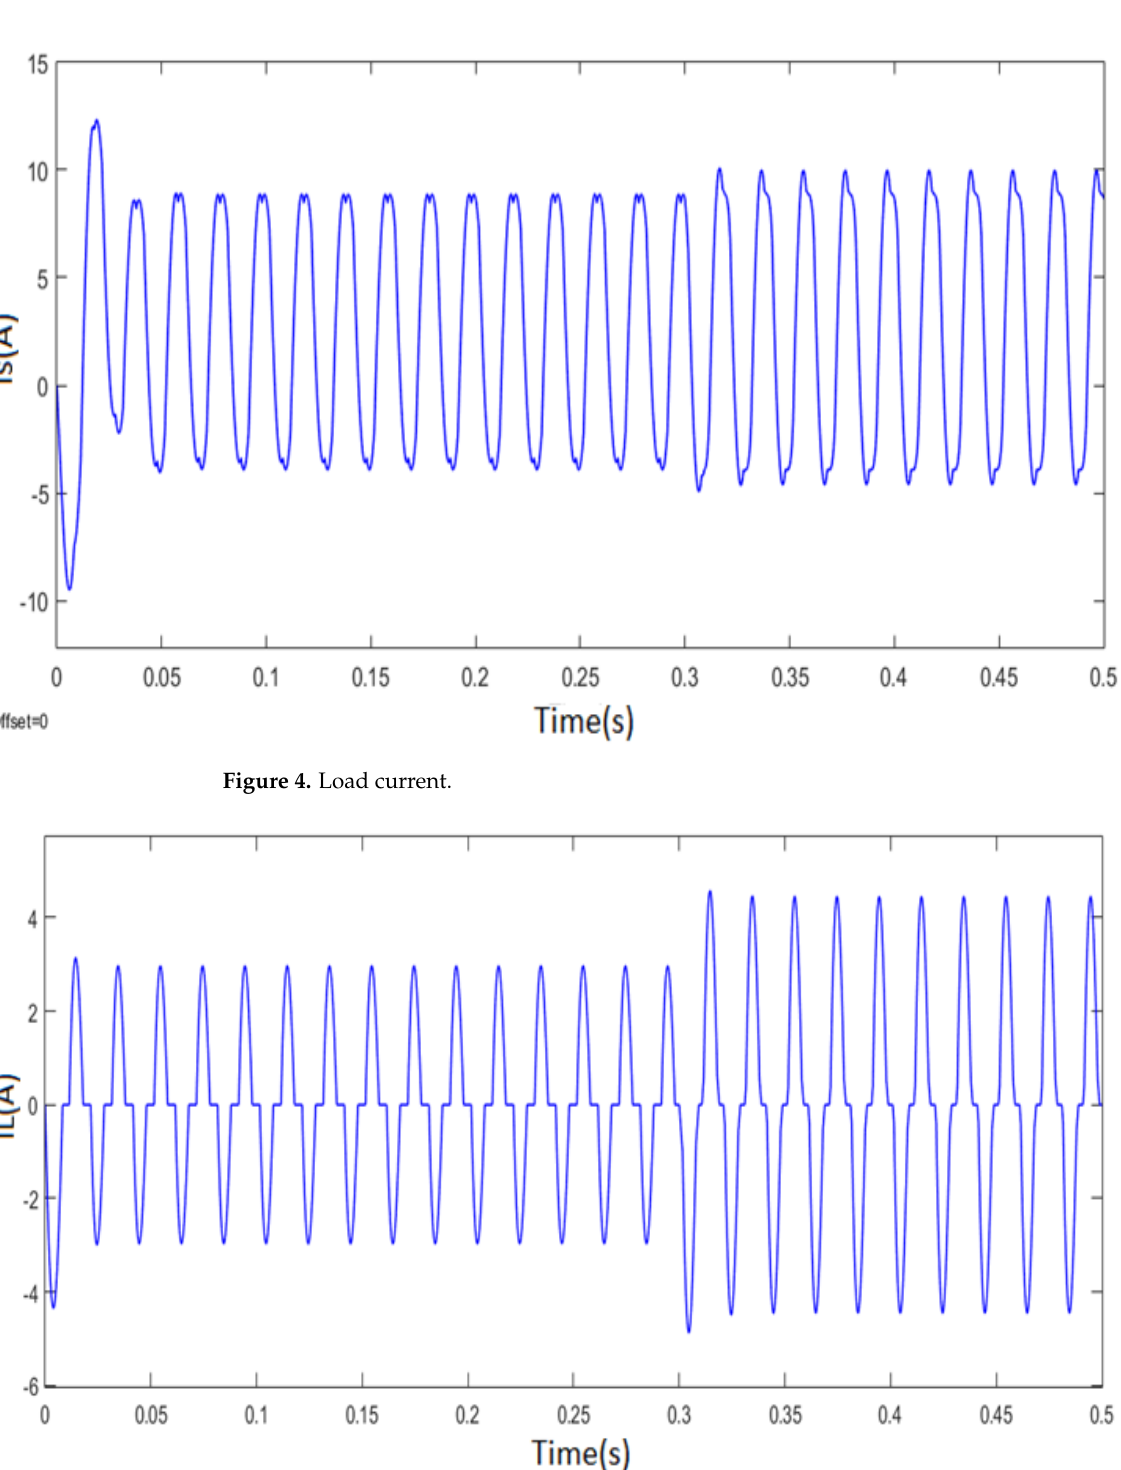
Figure 5. Power supply current.